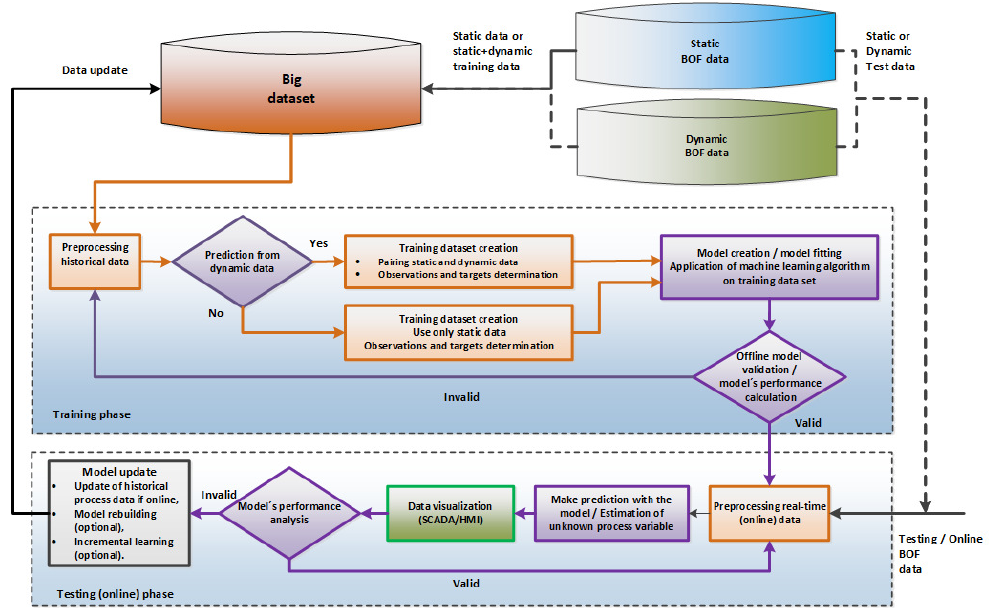
Figure 2. Idea scheme of modeling and prediction in steelmaking based on machine learning.